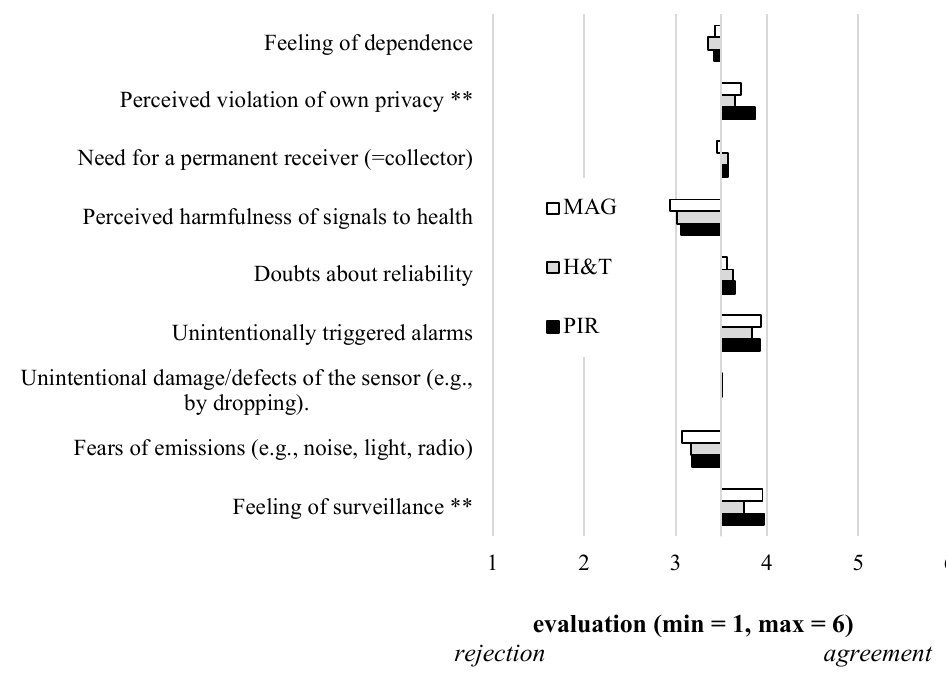
Figure 3. Users’ evaluation of perceived barriers of using three different sensor-based lifelogging technologies